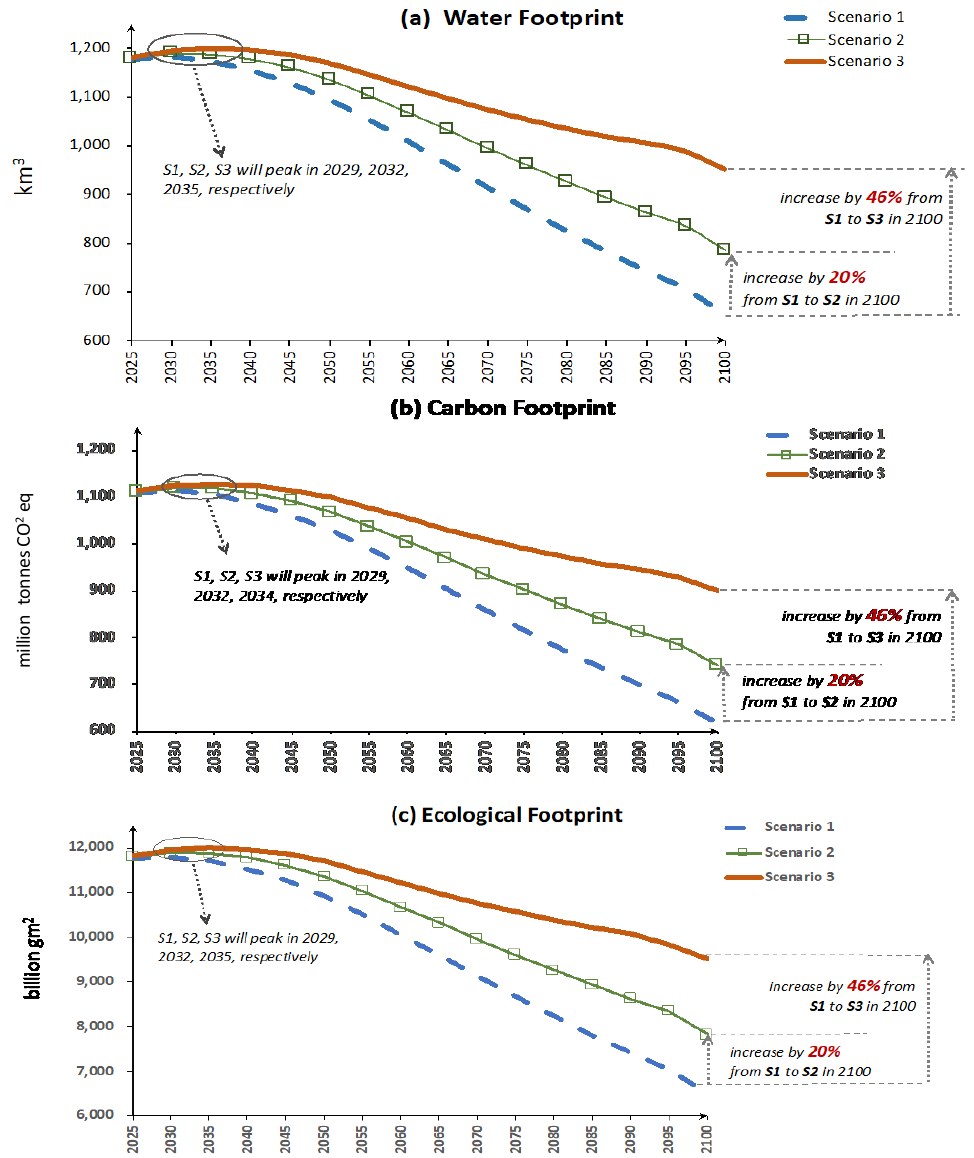
Figure 6. Future trends of food consumption’s total environmental footprint. where ( a ) stands for the trend of water footprint consumption of the food system over time, ( b ) is for the carbon footprint, and ( c ) is for ecological footprint.